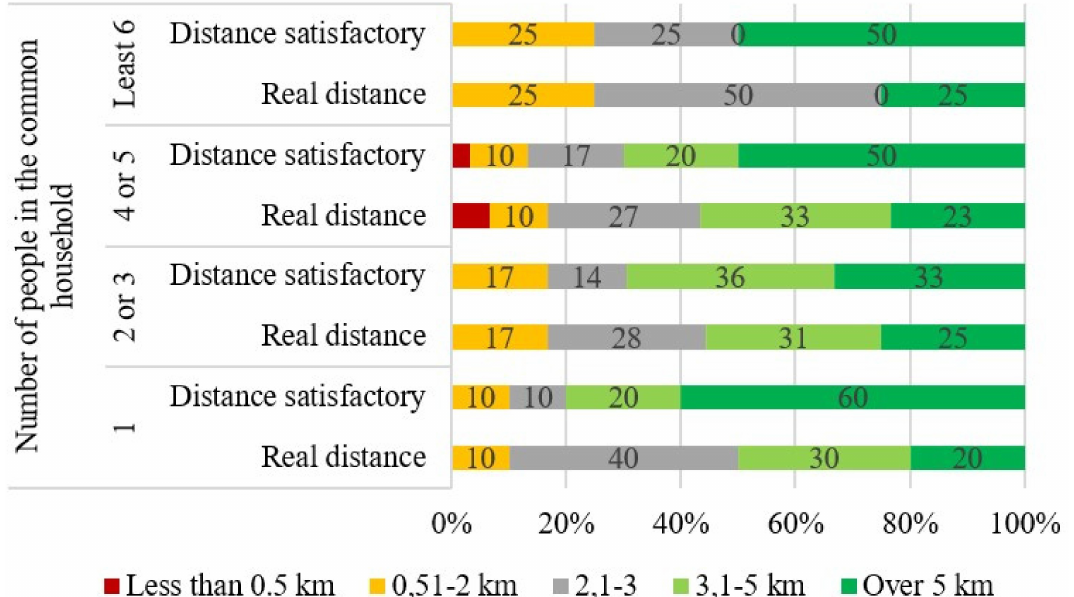
Figure 9. The indication of a satisfactory distance of the wind farm from buildings depending on the number of people in the household (%). Source: based on own